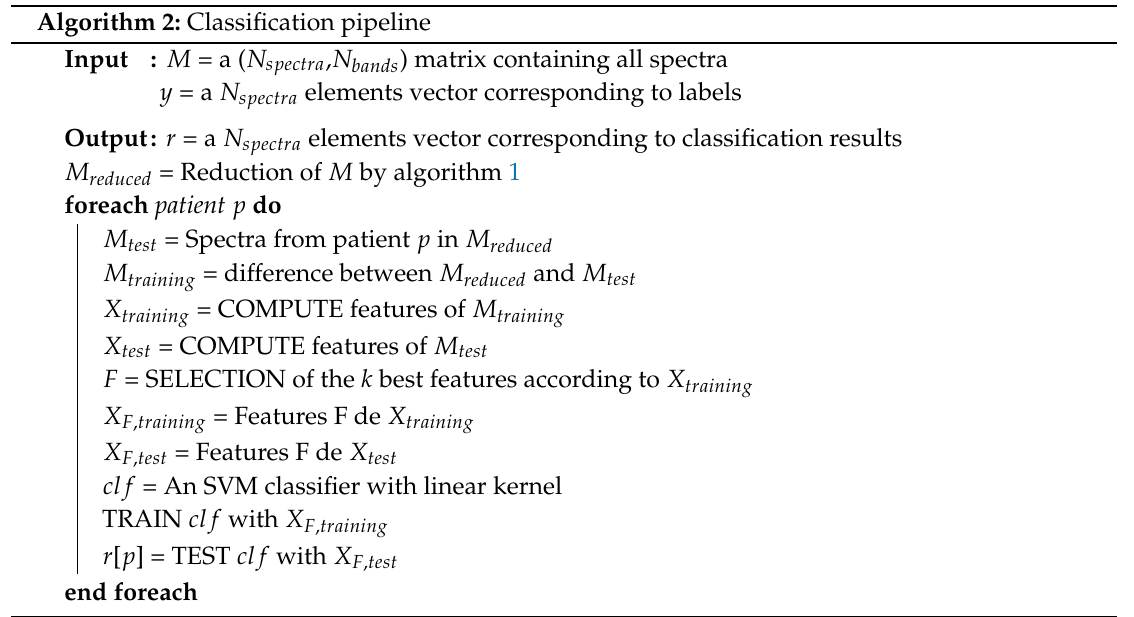
Algorithm 2: Classification